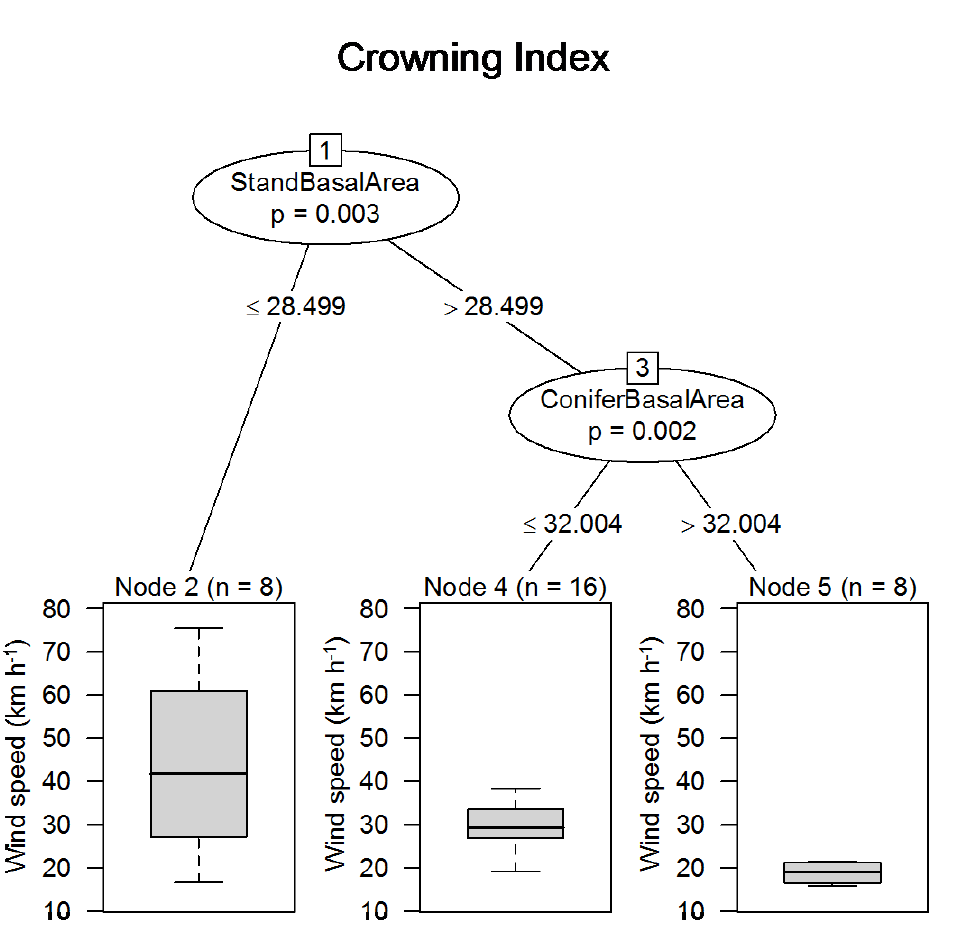
Figure 4. Classification tree results suggested two significantly different groups that influence crowning index: stand basal area and conifer basal